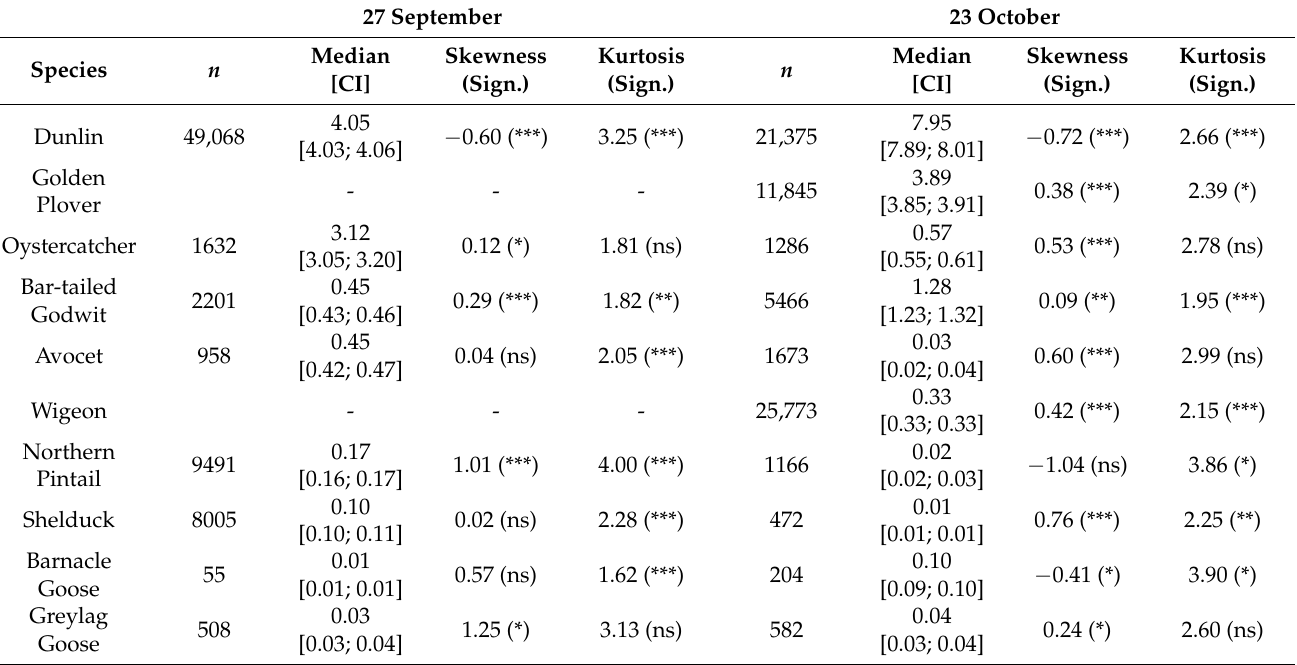
Table 1. Properties of the density distribution patterns for the 10 species investigated in this study measured for both field days, 27 September and 23 October. For each species, the median density (individuals per square meter) and confidence interval (CI) were calculated for the number of ob- served individuals ( n ). Furthermore, skewness (D’Agostino test) and kurtosis (Anscombe–Glynn test) were calculated. For both skewness and kurtosis, significance levels (sign.) are specified (ns = nonsignificant, “*” < 0.05, “**” < 0.01 and “***” < 0.001).